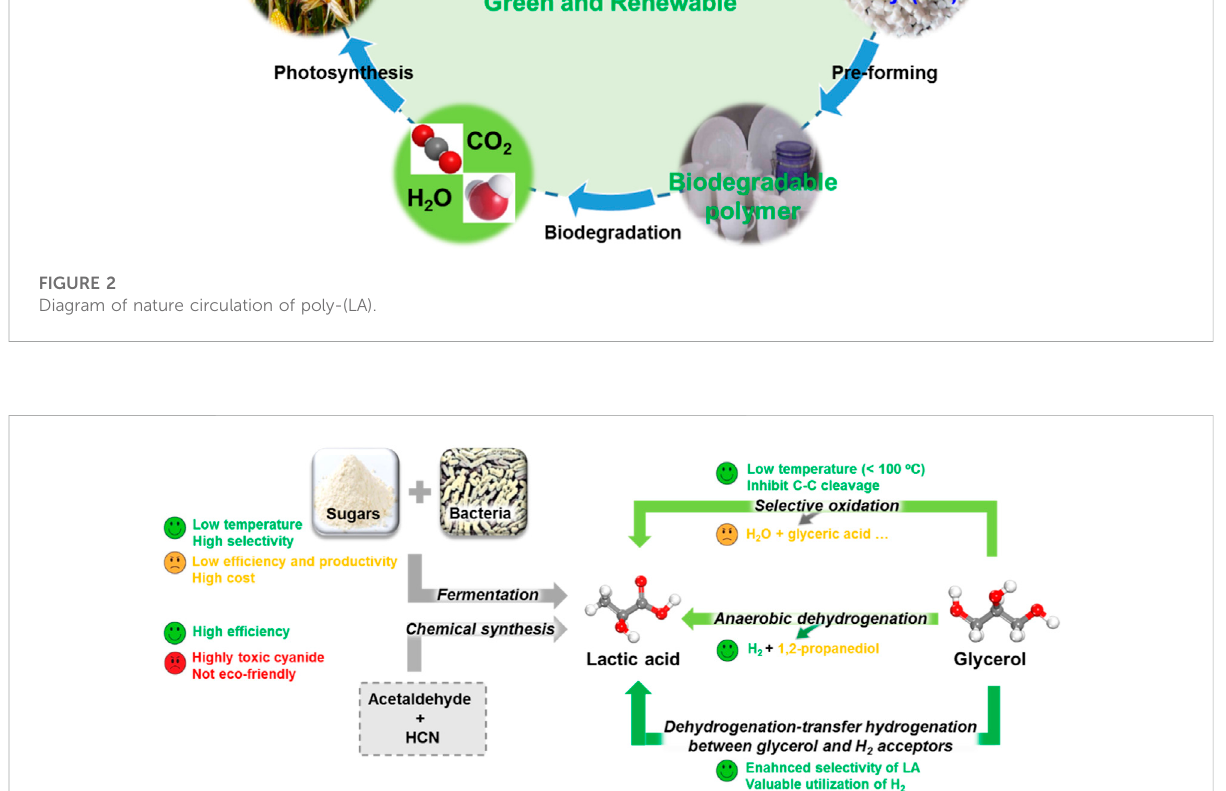
FIGURE 3 Comparison of various LA production processes (Zhang et al.,